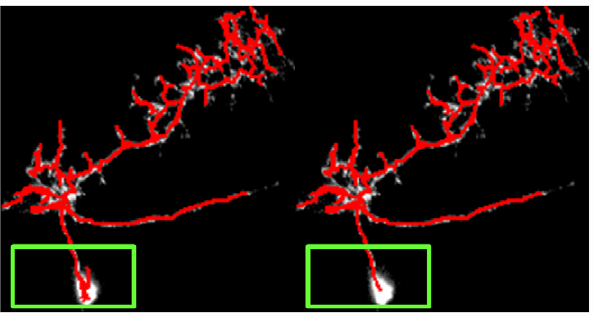
Figure 12. The results of before (left) and after (right) removing short branches inside the soma are demonstrated. The green rectangles indicate the somas.